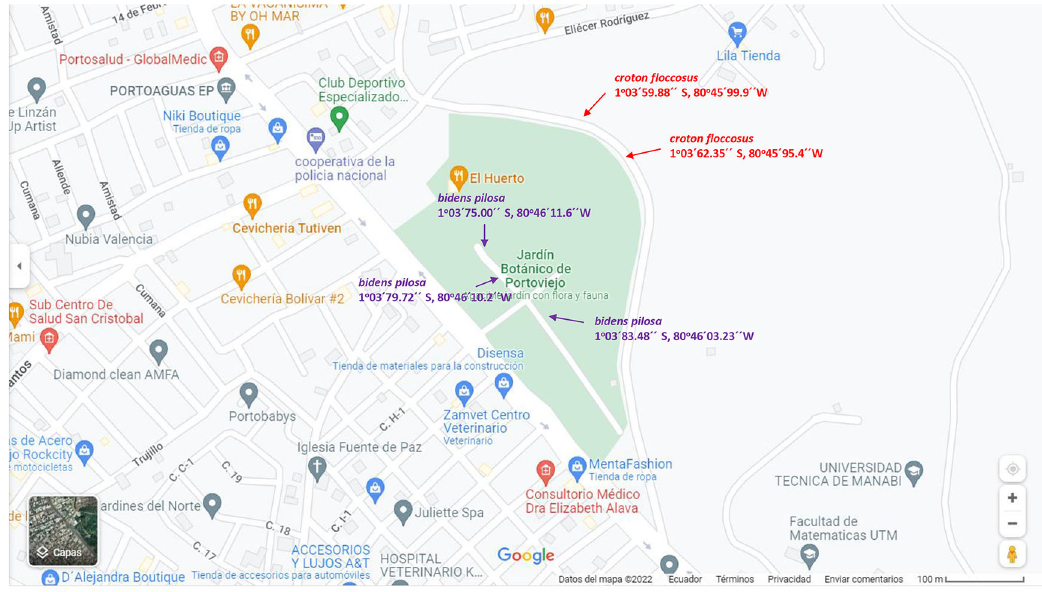
Figure 1. Map with the collection points of the studied species. Image obtained from Google